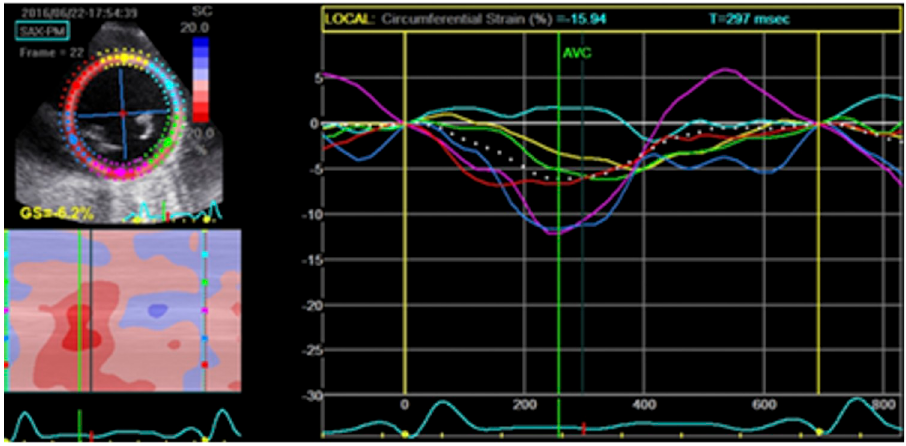
Fig 4. Left ventricular circumferential strain at the papillary muscles, with tracked of the six segments (left upper panel); M-mode representation of peak systolic strain (left lower panel); segmental end-systolic strain graphically displayed (left